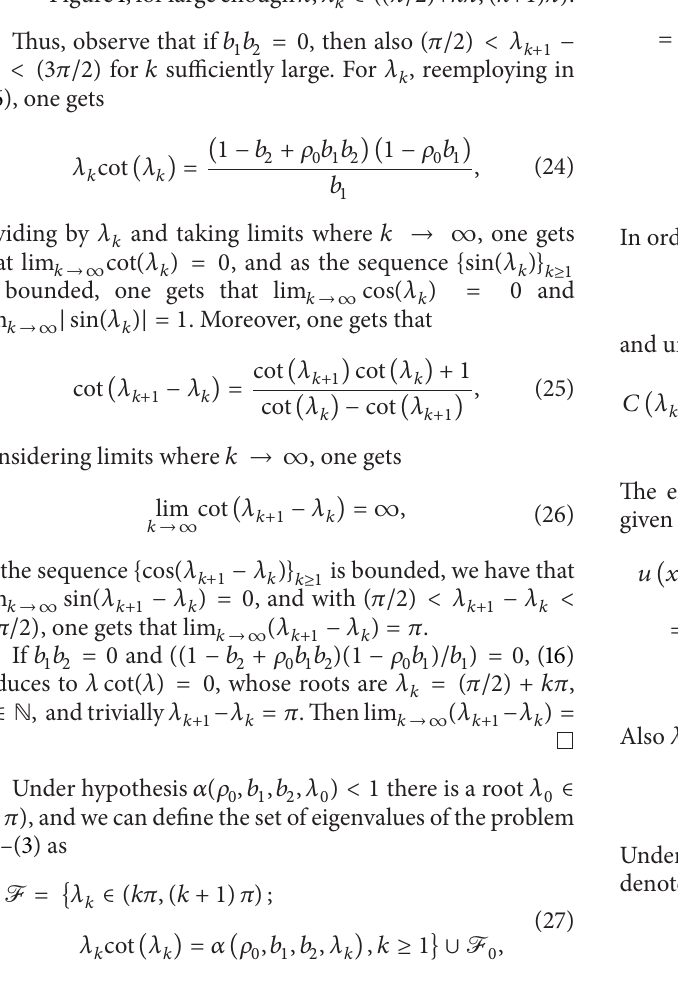
Figure 1, for large enough 𝑘 , 𝜆 𝑘 ∈ ((𝜋/2)+𝑘𝜋, (𝑘+1)𝜋)